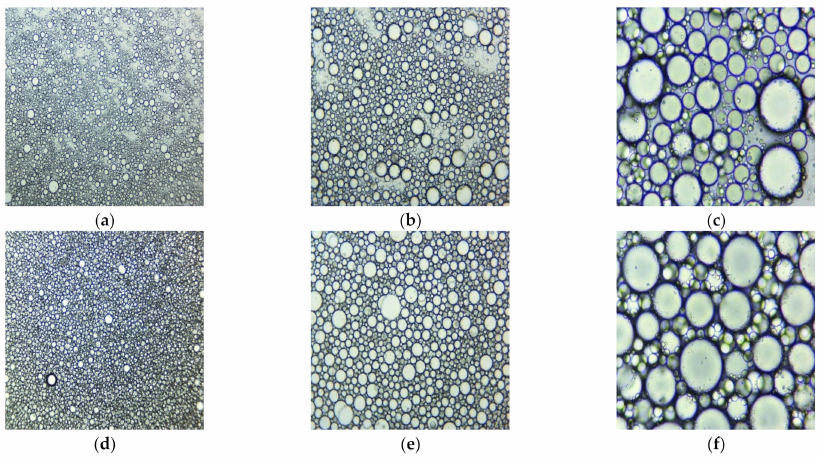
Figure 4. Microscopical images at 40 × , 100 × , and 400 × magnification of UBO ( a – c ) and CNO ( d – f ), emulsions: 40 × ( a , d ), 100 × ( b , e ), and 400 × ( c , f ) (20 ◦ C). After 24 and 30 h, the viability of A. salina larvae exposed to negative controls